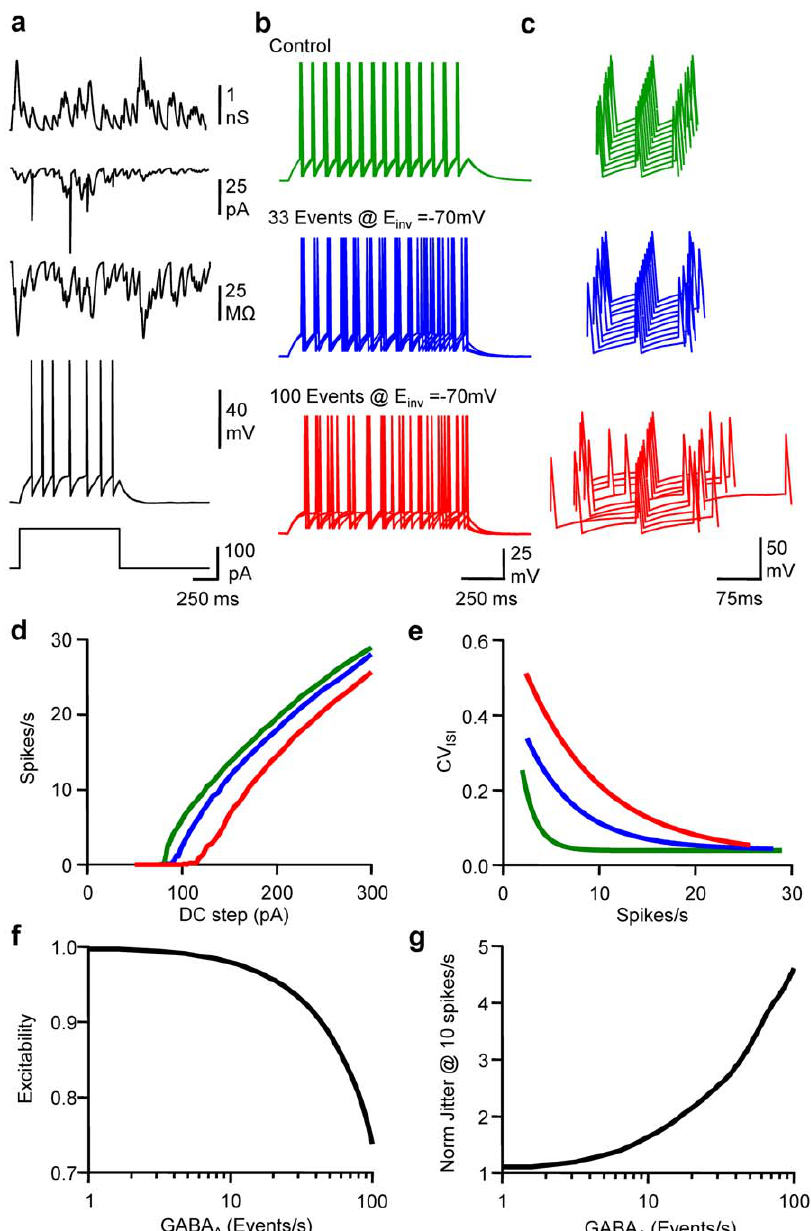
Figure 3. Modelling frequency-dependent tuning of neuronal excitability and spike timing. a, From upper to lower, an example of G GABA- A pattern of 33 events/s, I GABA-A , R in , Vm and a DC step (1 s, 120 pA) when running the LIF model. b, Superimposed (5) Vm fluctuations in response to a DC step (1 s, 160 pA) in control (green), in the presence of 33 (blue) or 100 (red) randomly occurring GABA A events/s with E GABA set at 2 70 mV. Same cell and colour code for c,d and e. c, Waterfall view of Vm when the 5 th spike was set as time reference. d, Mean Firing rate vs DC step. e, CV ISI vs firing rate. f, Normalised changes in excitability observed when LIF received 1 to 100 randomly occurring GABA A events/s. g, Normalised changes in spike jitter for a firing rate of 10 spikes/s. doi:10.1371/journal.pone.0022322.g003 between normalised jitter for an interpolated firing rate of 10 rightward according to E GABA . While major changes in CV ISI were observed for all firing rates tested at E GABA = 2 70 mV, they were negligible at E GABA = 2 30 mV. A series of experiments were performed with a broad range of E GABA (from 2 80 to 0 mV) in AP threshold. order to establish the relationship between E GABA , excitability and fidelity. Pyramidal neurone excitability was linearly dependent on E GABA and changes in excitability were abolished when E GABA was 6.1 mV under the AP threshold (n= 9; 95% confidence To further analyze the relationship between the reversal potential interval 10.3/1.9 mV under AP threshold). The relationship for GABA A receptors, the rate of firing and spike timing, an initial